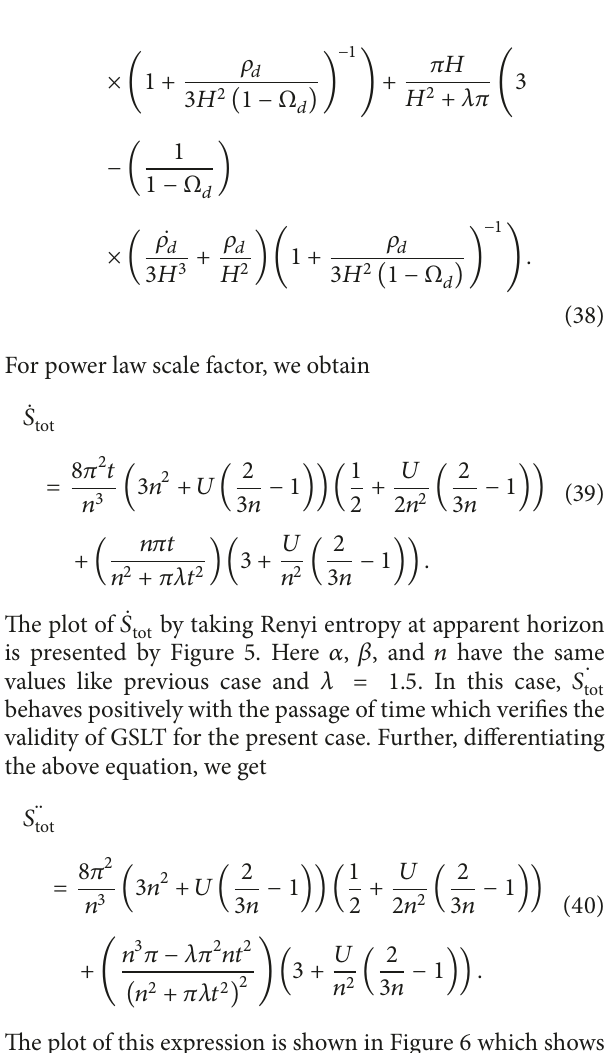
̈𝑆 Figure 4: Plot of 𝑋 = tot by taking Logarithmic entropy as entropy at apparent horizon, where time is measured in second.